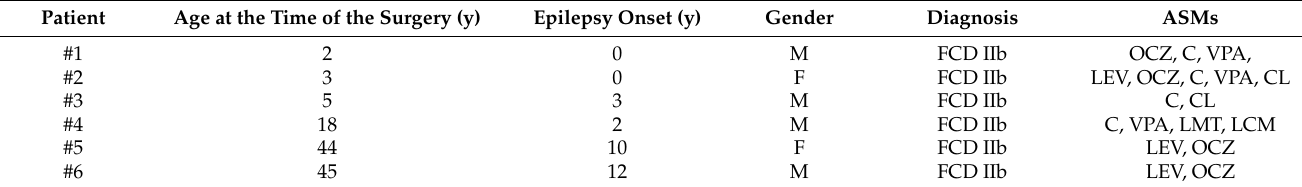
Table 1. Clinical characteristics of the